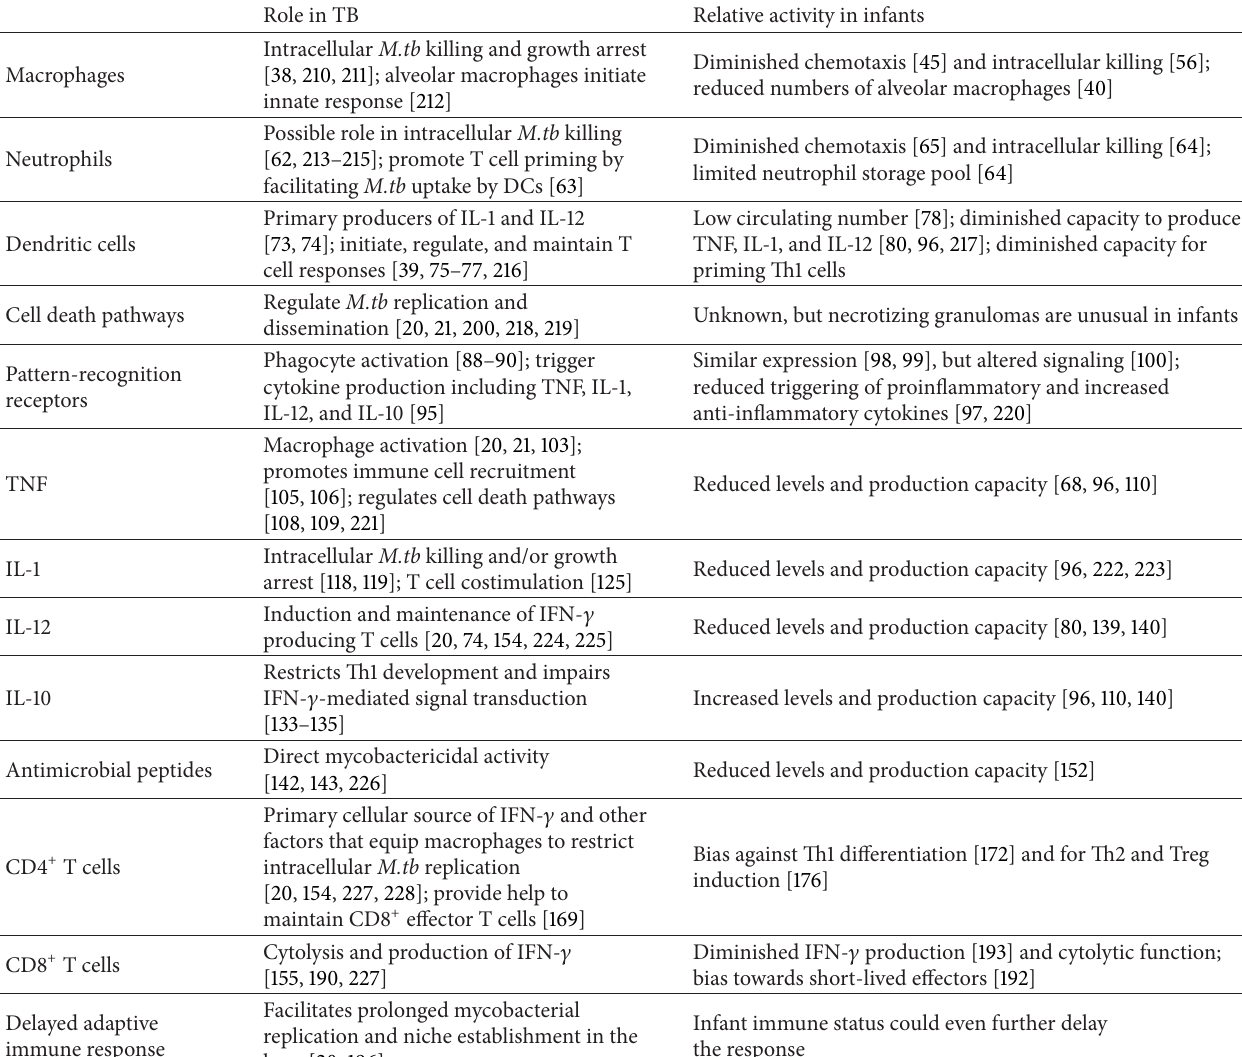
Table 1: Key elements of the immune response to TB with their activity in